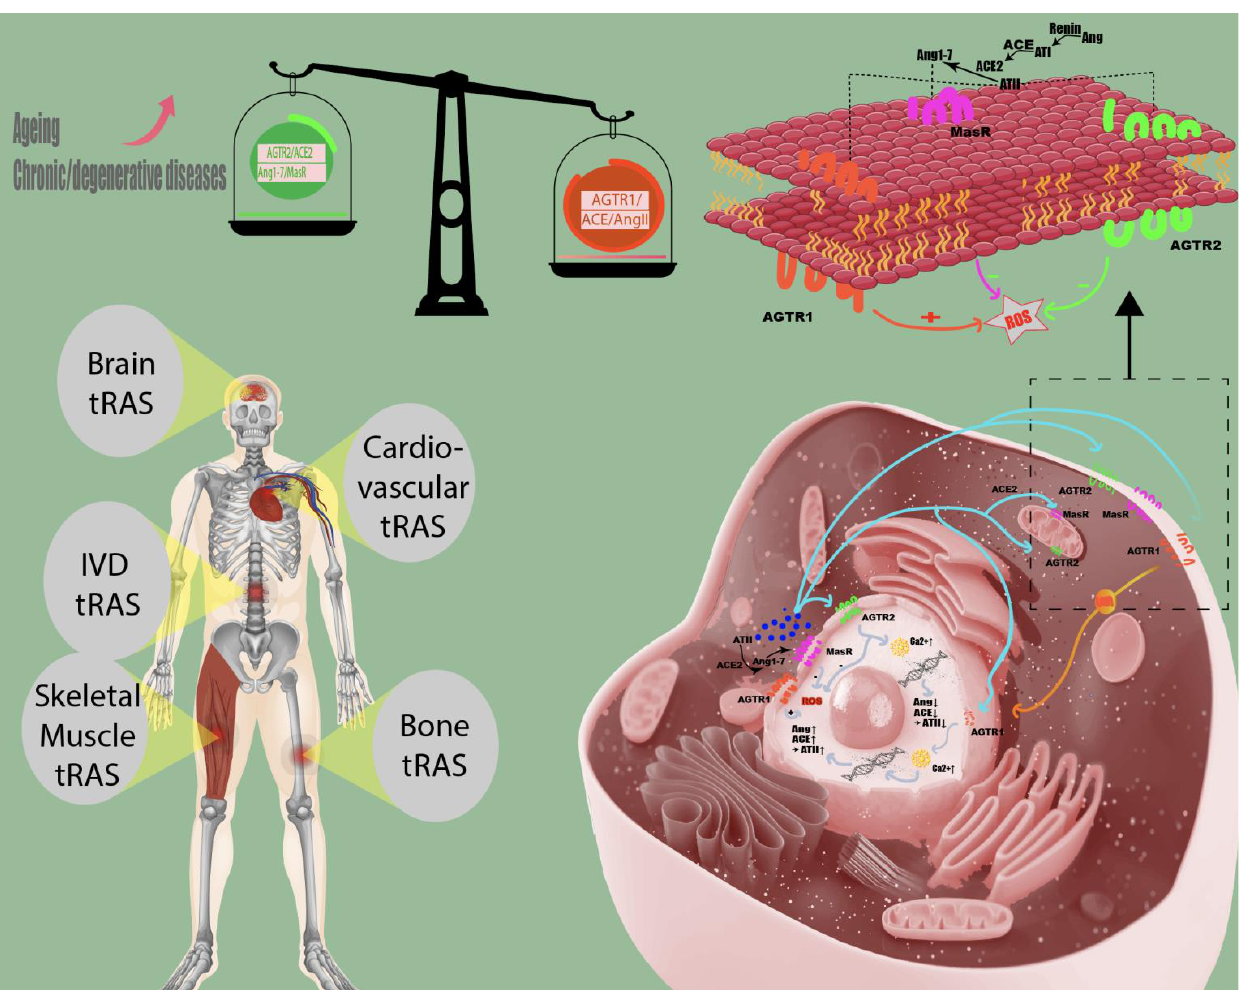
Figure 1. Tissue renin-angiotensin system in humans. Local renin-angiotensin systems are found in numerous human tissues, including skeletal muscle, bone, cardiovascular, brain, and intervertebral disc (IVD) tissue. The angiotensin II receptor type 2 (AGTR2) and the Ang1 – 7/Mas receptor (MasR) axis counteract the pro-inflammatory effects (increasing intracellular reactive oxygen species (ROS) of accumulating angiotensin II concentrations (AngII) on angiotensin II receptor type 1 (AGTR1). Chronic/degenerative disease states are characterized by the domination of the pathological tRAS pathway (angiotensin-converting enzyme (ACE)/AngII/AGTR1) over the protective axis (AGTR2/ACE2/Ang1 – 7/MasR), and aging might shift the balance between protective and pathological RAS axis towards AGTR1/ACE/AngII [2,3].